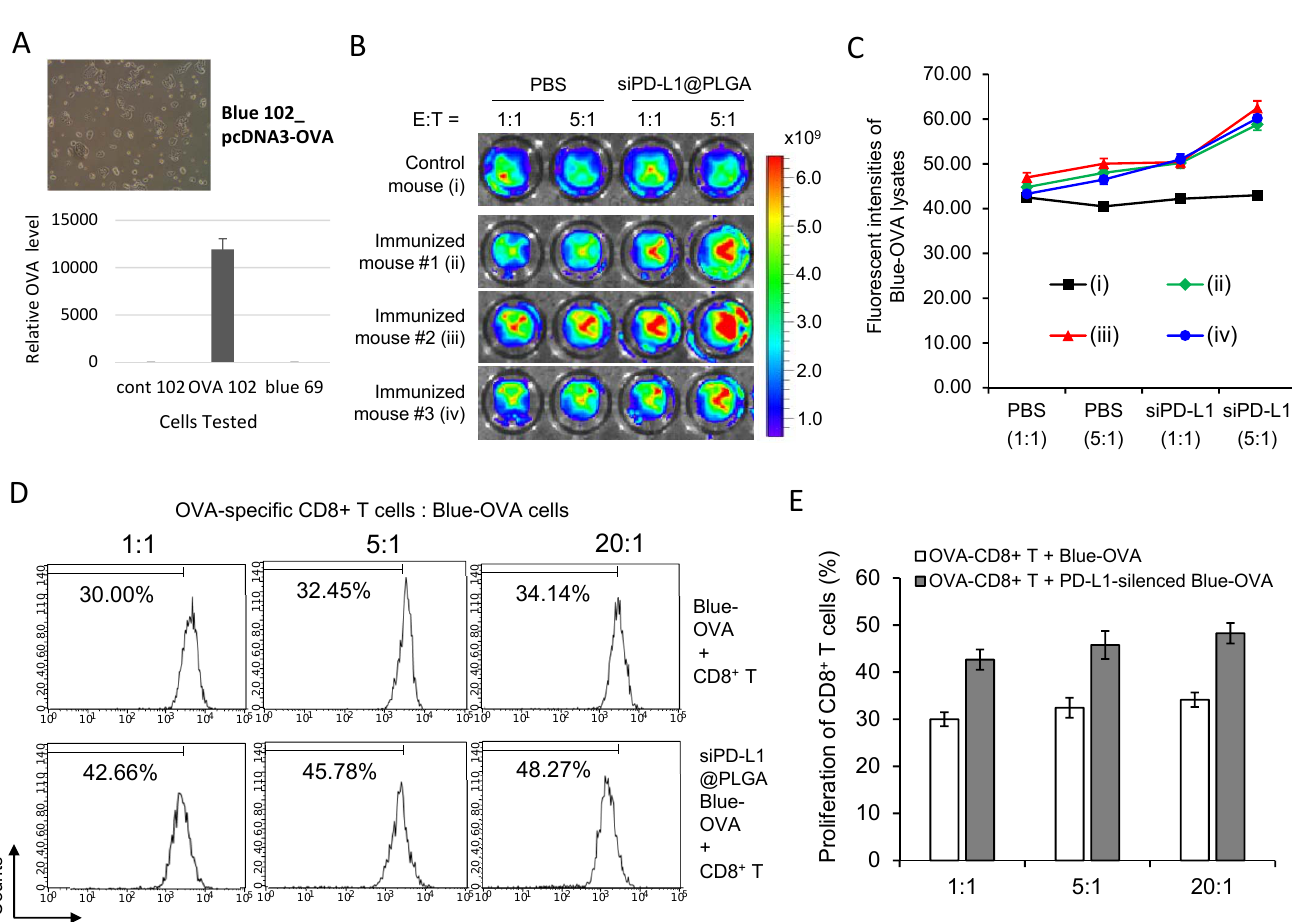
Figure 3. In vitro efficacy of siPD-L1@PLGA in OVA-specific T-cell immunity. ( A ) Generation of PDAC cells with stable OVA expression. The left panel shows a photograph of the OVA cells, and the right panel shows the Ova RNA level. ( B , C ) Cytolytic activity of OVA-specific CD8 + T cells exhibiting antitumor T-cell immunity. OVA-specific CD8 + T cells were isolated from the immunized OT-1 mice with the OVA peptide (SIINFEKL) and adjuvant (ii–iv) and then re-stimulated using OVA peptide-loaded PLGA NPs and recombinant mouse IL-2. Blue-OVA cells were transfected with siPD-L1@PLGA NPs or PBS for 4 h and incubated for 40 h. Next, the treated Blue-OVA cells (target cells) were stained with CellTracker Deep Red dye and then co-cultured with OVA-specific CD8 + T cells (effector cells) at a ratio of 1:1 or 1:5 (E:T) for 4 h. The FI derived from the contents of lysed Blue-OVA cells was measured ( B ), and the percent specific lysis was calculated and plotted ( C ). OVA-nonspecific CD8 + T cells isolated from non-immunized C57BL/6 mice (i) were used as a control. The results are presented as the mean ± SD ( n = 3). ( D , E ) Promoted expansion of CTLs induced by silencing of PD-L1 in the co-culture system of OVA-specific CD8 + T cells and Blue-OVA cells. OVA-specific CD8 + T cells were isolated from the in vivo-immunized OT-1 mice with the OVA peptide and adjuvant and then re-stimulated. Blue-OVA cells transfected with siPD-L1@PLGA NPs were co-cultured with CFSE-labeled OVA-specific CD8 + T cells at an E:T ratio of 1:1 or 1:5 for 3 d. The proliferation of CTLs was examined via FACS analysis ( D ) and then plotted in comparison with the co-culture samples without siPD-L1@PLGA transfection ( E ). The results are presented as the mean ± SD ( n =